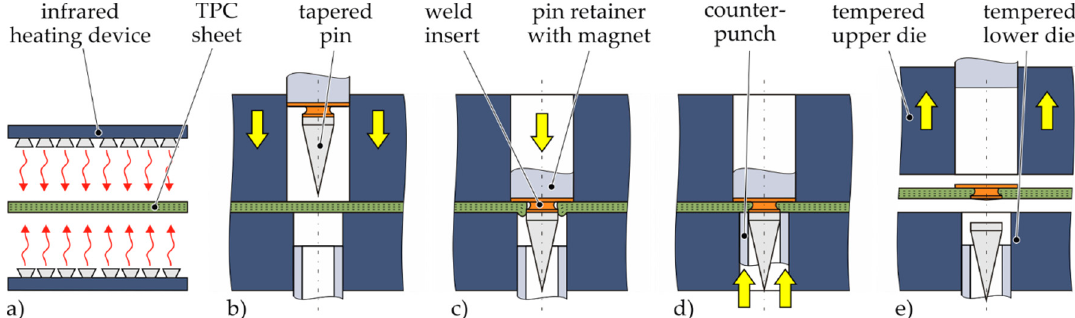
Figure 1. Schematic illustration of process-integrated embedding of weld inserts in thermoplastic composites (TPC): ( a ) warming up the TPC sheet, ( b ) closing the compression mould, ( c ) shifting forward the pin tool, ( d ) recompressing the squeezed-out material by the counterpunch, ( e ) demoulding of the TPC specimen.